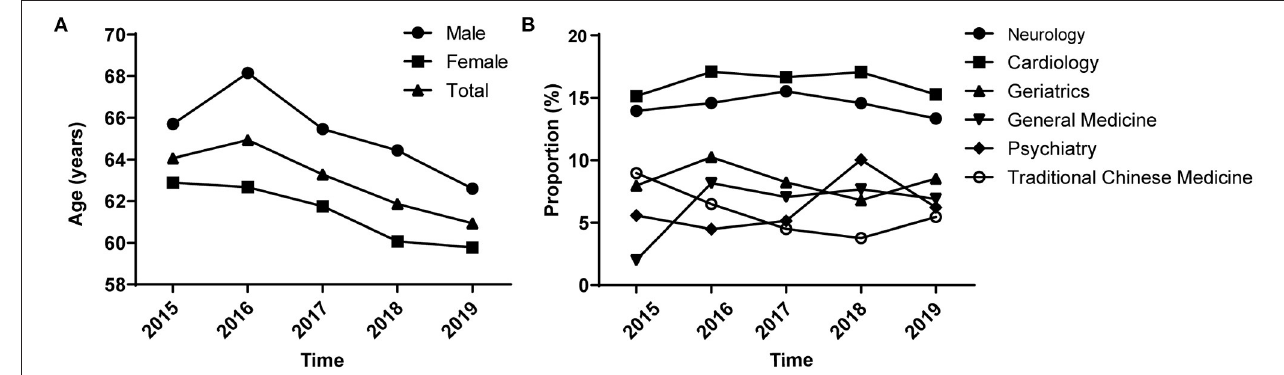
FIGURE 1 | Trends of outpatients with insomnia analyzed according to sex and clinical department between 2015 and 2019. (A) Age trends of outpatients with insomnia by sex. (B) Trends by clinical department.